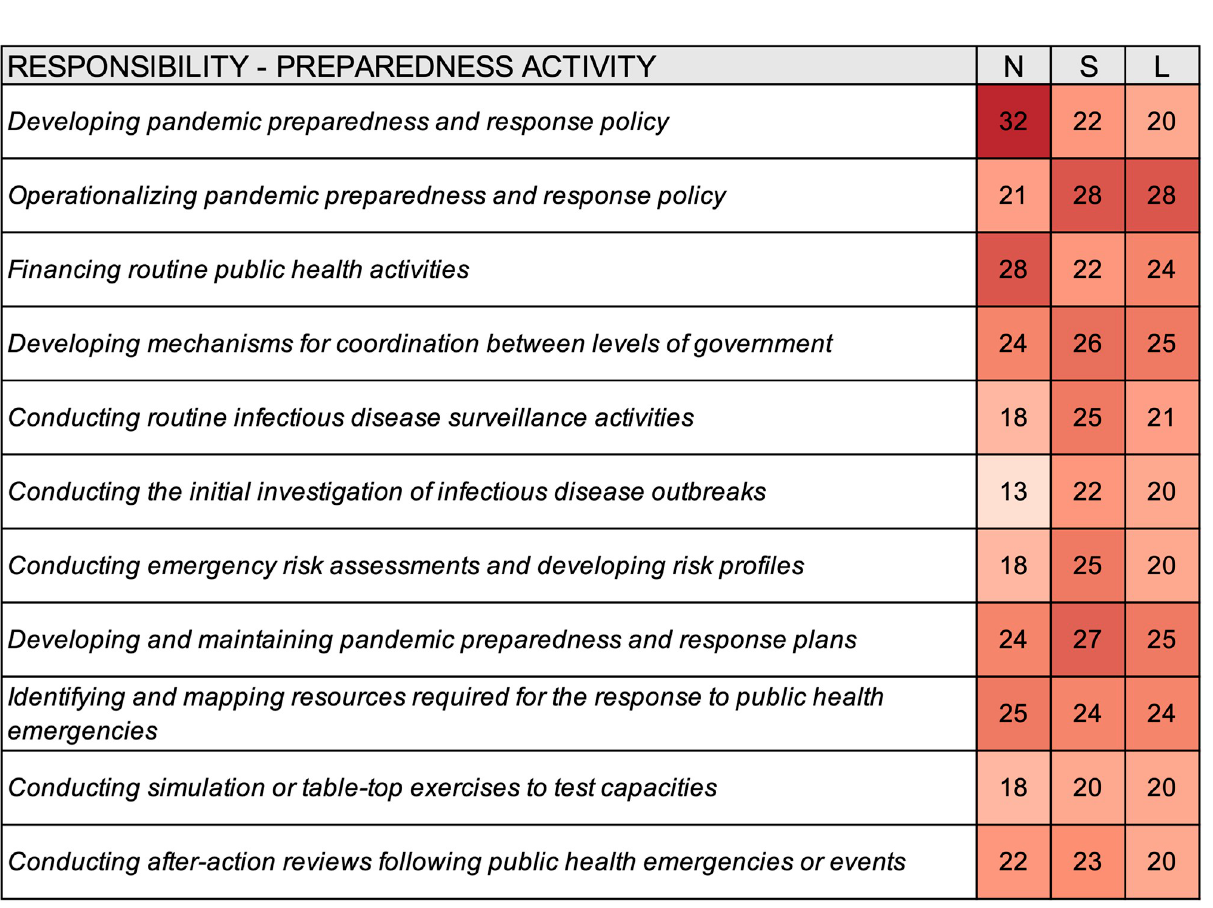
Fig 2. Heat map summarizing the responsibility for select preparedness activities for different levels of government according to survey responses from thirty-three cities. N–National, S–Subnational, L–Local.